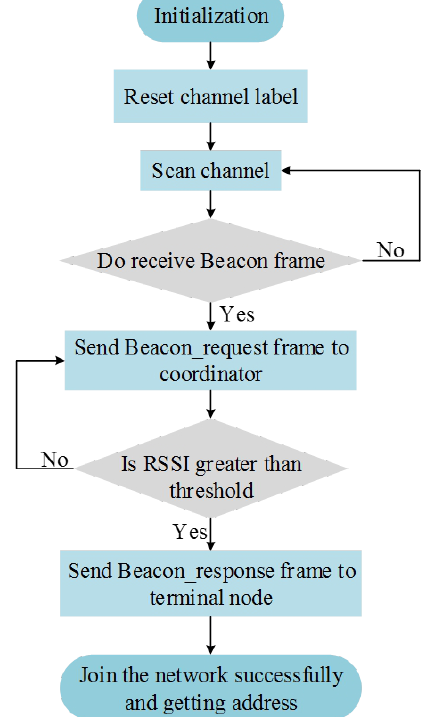
Figure 3. Flowchart of the nodes joining the